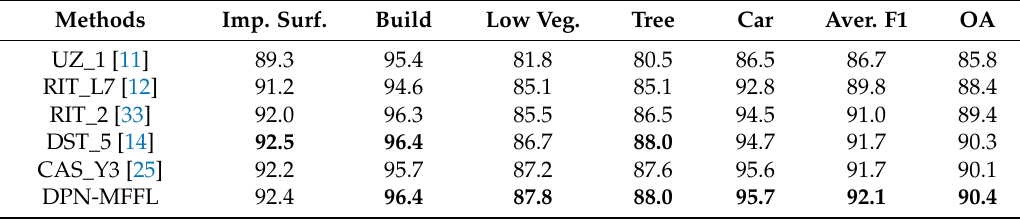
Table 3. Experimental results on the ISPRS Potsdam challenge online test